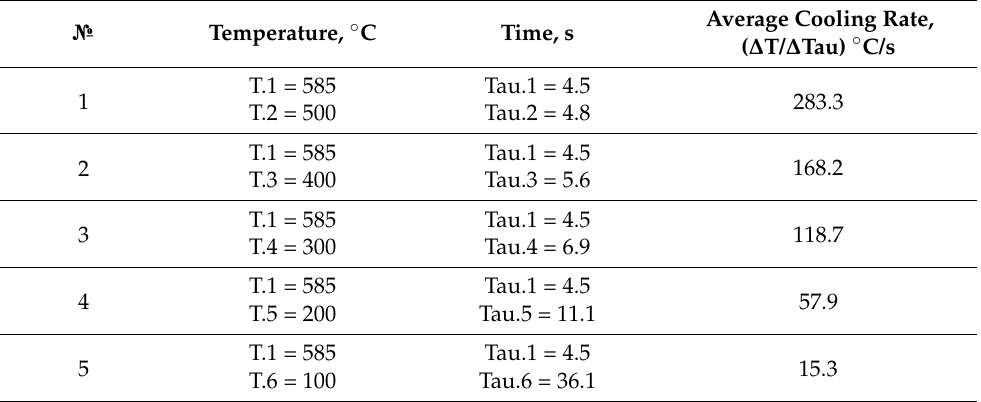
Table 4. Average cooling rates for temperature